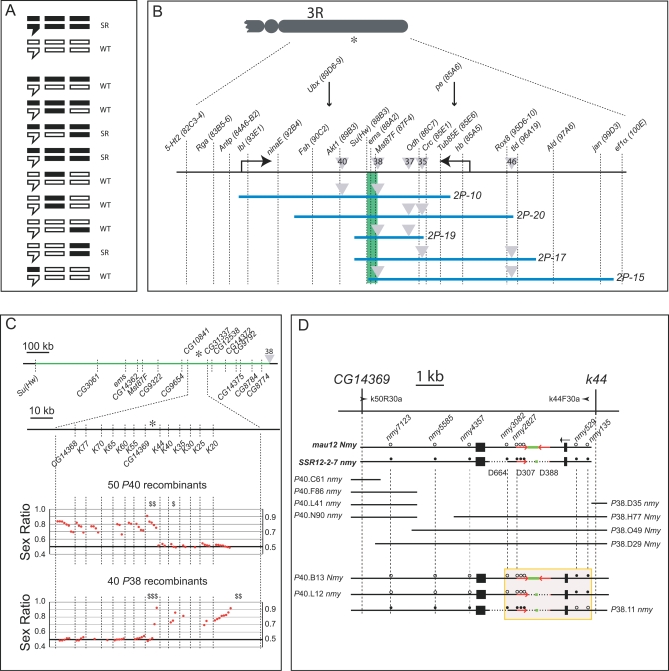
Positional Cloning of not much yang, a Recessive Autosomal sex-ratio Suppressor on the Third Chromosome(A) A recessive gene on the third chromosome was implicated for uncovering sex-ratio. Through various crossing schemes (see Text S1 for details), chromosomal combinations from sex-ratio (black) and wild-type (white) strains were tested for sex-ratio. In each genotype, bars from left to right represent the X, the second, and the third chromosome, respectively. The bar with a hook represents the Y chromosome. The fourth chromosome was not followed. SR: sex-ratio; WT: wild type (not sex-ratio).(B) A major gene was mapped between P40 and P38 on the right arm of the third chromosome (3R). Shown here are the 2-P lines used in the mapping, with the blue bars representing the D. mauritiana portion of the introgression lines and the gray triangles representing the P[w
+] inserts (see Figure S6 for details). The two bent arrows represent the 84F-93F inversion in D. simulans complex as compared to D. melanogaster. Dotted lines represent ASO markers. The target gene (*) falls within the green region that was subsequently mapped in more detail.(C) Fine mapping at 1-kb resolution. Fifty P40 and 40 P38 recombinants were found with their crossovers falling in the CG10841–CG31337 region. The positions of these crossovers were delimited with 13 ASO markers. The sex ratio (proportion of female) for each recombinant is shown here in rank order within each ASO interval. Significant among-recombinant variation in sex ratio is indicated (one-way ANOVA: $, p < 5%; $$, p < 1%, and $$$, p < 0.1%). The target major gene (*) is mapped to the 7-kb interval of CG14369–K44.(D) Two insertions/deletions are responsible for the nmy phenotype. The parental sequences from D. mauritiana w (mau12 Nmy) and D. simulans SSR12-2-7 nmy were amplified by long PCR using the primers k50R30a and k44F30a (arrow heads, see Text S2 for sequences). Empty and filled circles represent a subset of the informative substitutions. The filled rectangles represent the coding sequence of CG14370, which is a single exon gene in D. melanogaster. The sequences between the two filled rectangles, 2,791 bp in mau12 Nmy and 1,427 bp in SSR12-2-7 nmy, are missing in D. melanogaster. The arrow represents the transcription orientation. Dashed lines represent, from left to right, three large deletions of 664, 307, and 388 bp in SSR12-2-7 nmy, respectively. The red arrows stand for inverted repeats (IR) of 380 bp in mau12 Nmy, and a 345-bp homolog in the SSR12-2-7 nmy allele. The green lines represent sequences between the IRs. The last informative 11 recombinants were genotyped with seven ASO probes (nmy135 – nmy7123). Eight of the 11 recombinants (P40.C61 to P38.D29) are shown with their D. mauritiana portions (bars). The three most informative recombinants were sequenced with their crossovers precisely determined. The only difference between P40.B13 Nmy and P40.L12 nmy is the last two insertions/deletions (shaded box).